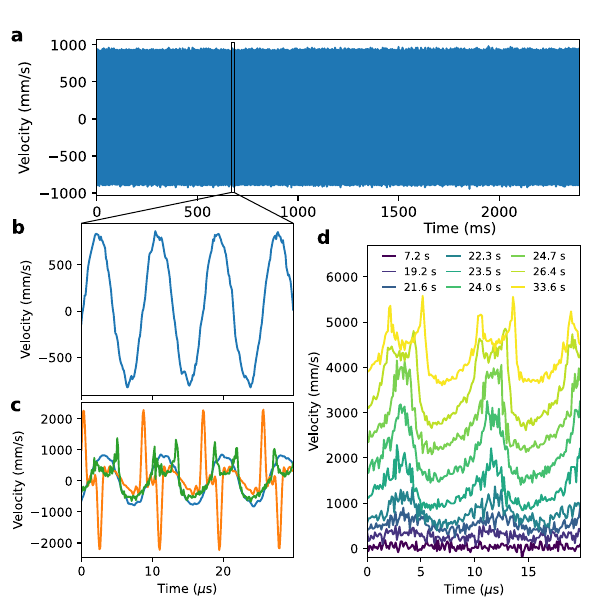
Fig. 3 | Comb dynamics. a Measured displacement of membrane, showing clear growth before reaching a plateau around t =24s. b Measured spectrum of mem- branemotionclosetofundamentalmodeandtwoofitsovertones(5thand15th).A thermalshiftof9Hzofthefundamentalmodeisvisibleasa5×9and15×9Hzshift in the overtones (white dashed lines are horizontal to guide the eye). c : First six overtonesincreaseinpowerasthemembranedisplacementincreases(markers)in a ,withsimulateddynamics(solidlines)basedontheintegrationofEq.(1)matching quantitatively to the highest four. d Membrane displacement of a different device